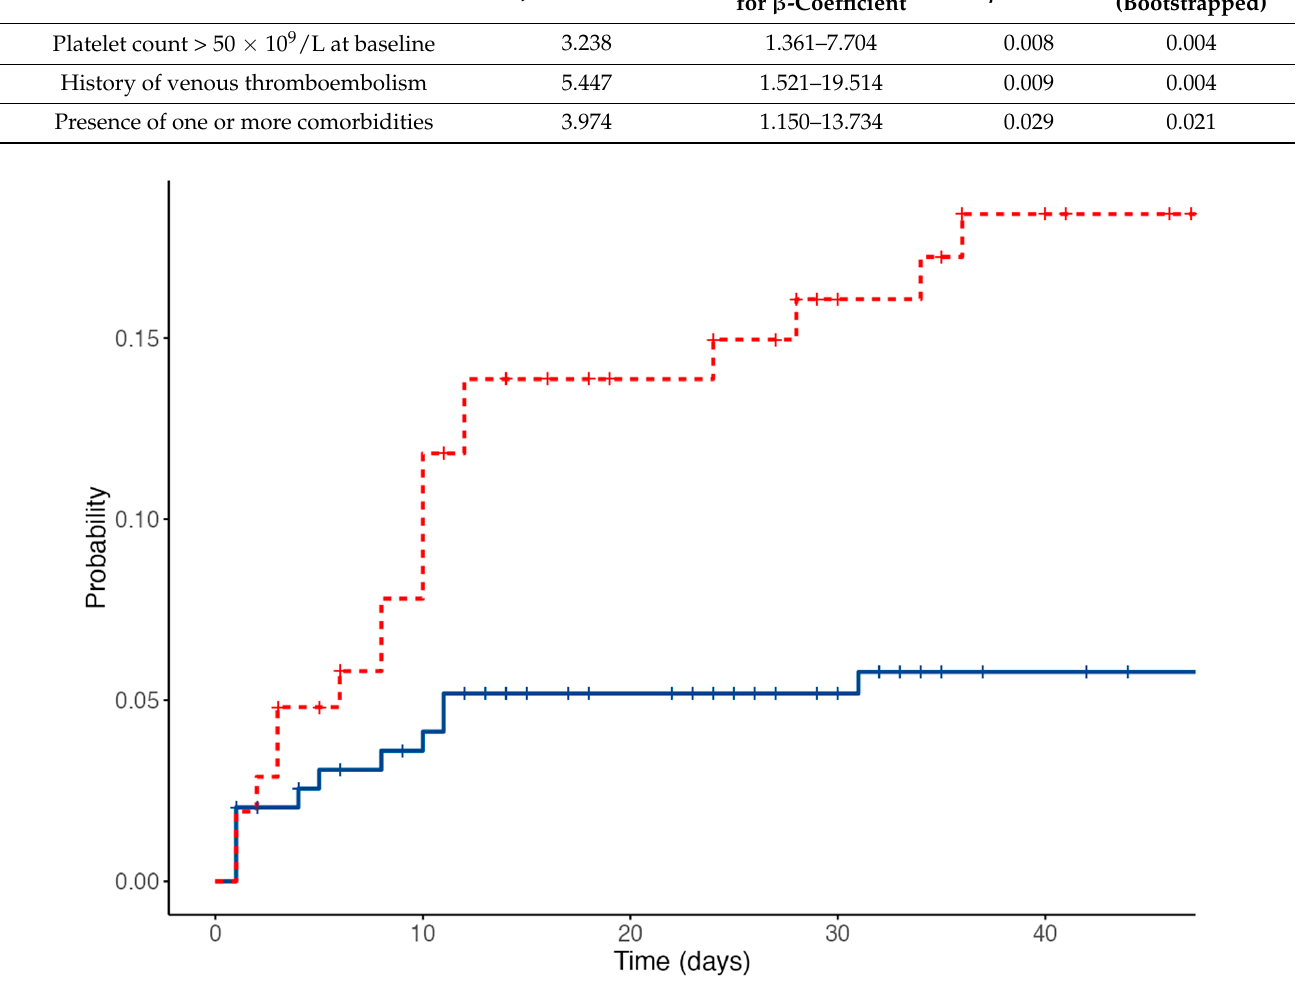
Table 3. Logistic regression model for occurrence of venous thromboembolism within 45 days from acute myeloid leukemia diagnosis.